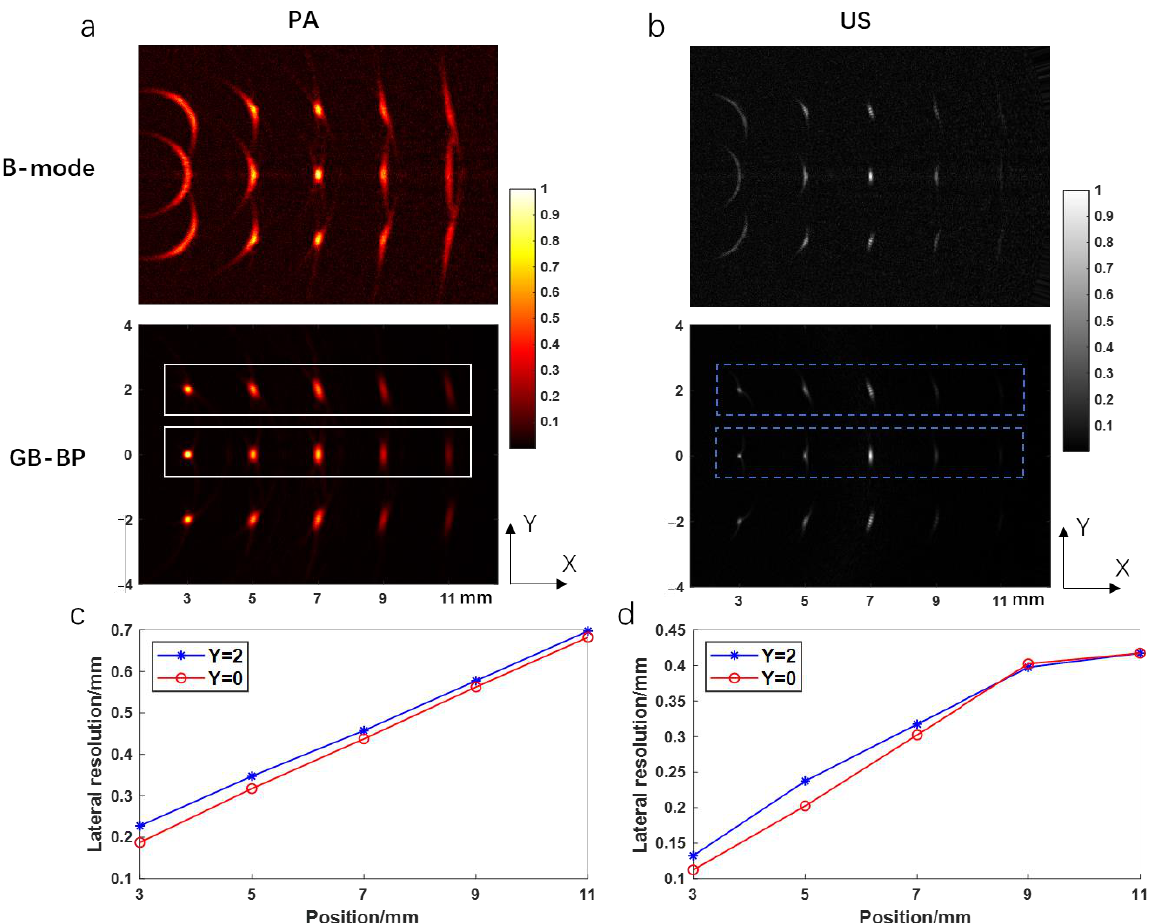
Figure 5. ( a ) The photoacoustic images reconstructed by the B-mode method and GB-BP algorithm; ( b ) The ultrasonic images reconstructed by the B-mode method and GB-BP algorithm; ( c ) Lateral resolution of the targets in the white solid line box in ( a ); ( d ) Lateral resolution of the targets in the blue dashed box in ( b ). Coordinate axis units are millimeters.